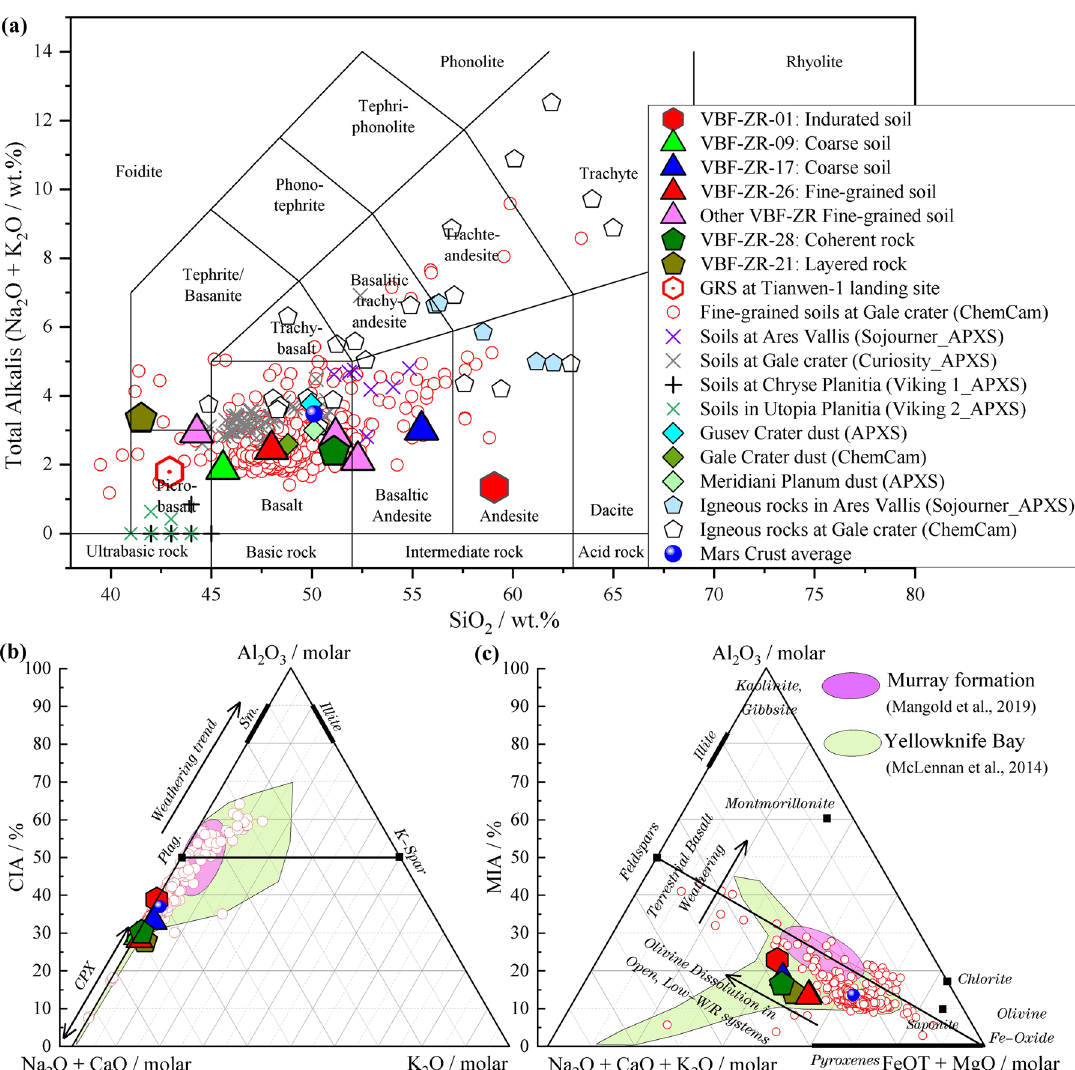
Fig. 4 Geochemical results of selected VBF-ZR targets. a Total alkalis (Na 2 O and K 2 O) vs. silica diagram of VBF-ZR targets that does not take into account sedimentary processes. Data of soils, dust, and rocks acquired by other missions are from Bridges et al. 75 , Berger et al. 43 , Lasue et al. 40 , and Mangold et al. 55 . Compositions of fi ne-grained soils at Gale crater (red circle) are from PDS Geosciences Node at Washington University in St. Louis. b , c Ternary diagrams of Al 2 O 3 -(CaO + Na 2 O)-K 2 O and Al 2 O 3 -(CaO + Na 2 O + K 2 O)-(FeO T + MgO), with CIA and MIA values on the vertical axis. ChemCam results from Murray formation and Yellowknife Bay in Gale crater are respectively from Mangold et al. 55 and McLennan et al. 53 . The average compositions of Mars crust are from Taylor et al. 51 . The big size of VBF-ZR data represents the currently used percent level (wt%) accuracy for them, which will be improved along with the Tianwen-1 mission